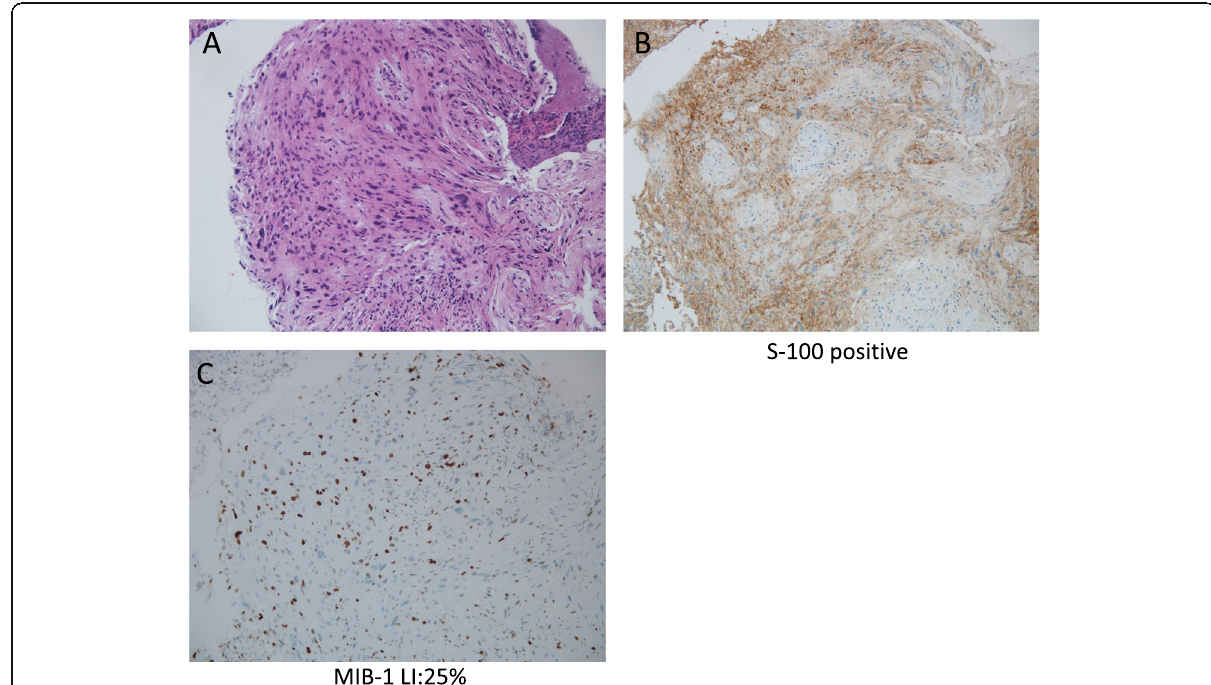
Fig. 3 a Histopathological findings of the biopsy sample. The pathological specimen revealed that spindle cells with different-sized nuclei were mixed throughout the tissue. b Immunostaining showed S-100-positive staining. c Immunostaining showed MIB-1-positive staining. The MIB-1 LI was approximately